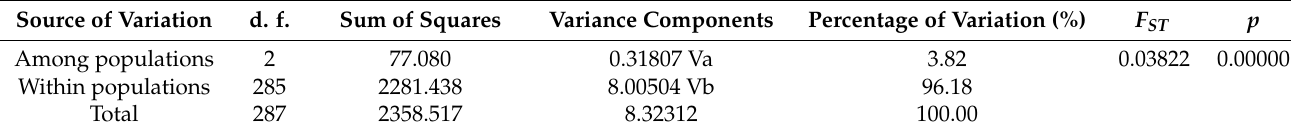
Table 4. AMOVA results for Eriocheir s. s. populations.